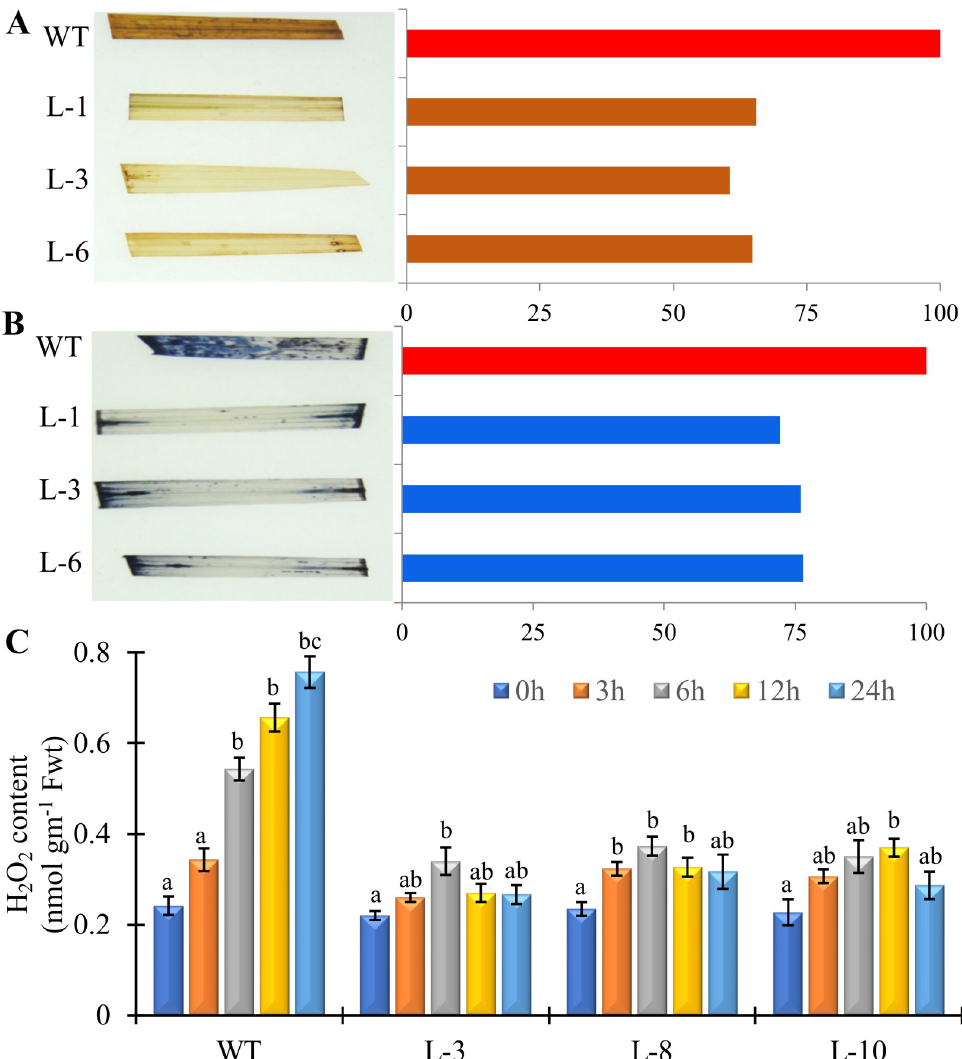
Fig 3. Accumulation of reactive oxygen species in the WT and PgGPx transgenic plants in response to exogenous Cd 2 + stress. Accumulation of H 2.- (B) in the transgenic and WT plants under Cd 2+ stress was assessed by 2 O 2 (A) and O histochemical 3,3’-diaminobenzidine (DAB) and nitro blue tetrazolium (NBT) staining, respectively. (C) Total H 2 O 2 content was measured from the transgenic and WT plants. Data represent as mean value ± standard deviation of three biological replicates (n = 3). Different letters above the bar showed significant difference between the treatments and plant genotypes (P < 0.05, ANOVA; post hoc